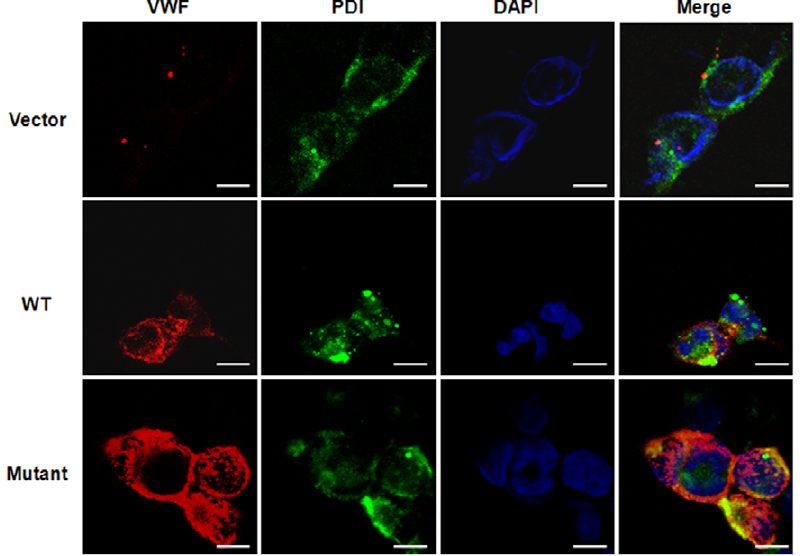
Figure 5. Detection of WT and mutant VWF in transfected HEK293 cells by immunostaining. HEK293 cells were transfected with a control vector or plasmids expressing WT or mutant VWF. The cells were stained for VWF (red), PDI (green) or DAPI (nucleus, blue). In the right column panels, merged pictures of green, red and blue channels are shown. The images were obtained with a confocal microscope. Scale bars: 10 m m.